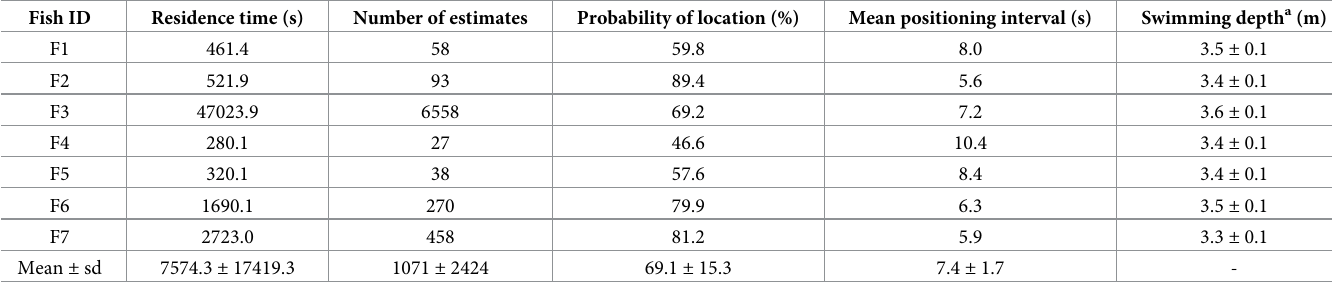
Table 5. Positioning results within the array of the seven tagged Siebold’s